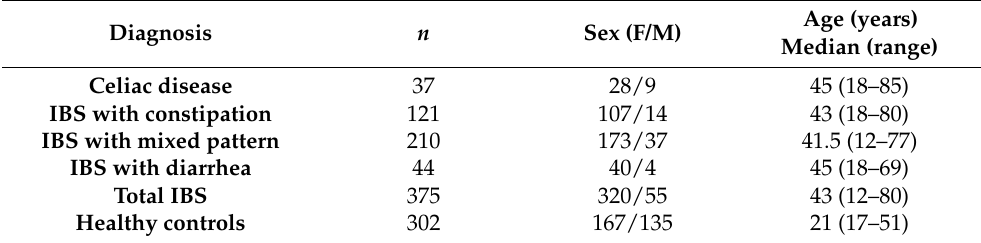
Table 1. Demographics and clinical characteristics of patients and healthy